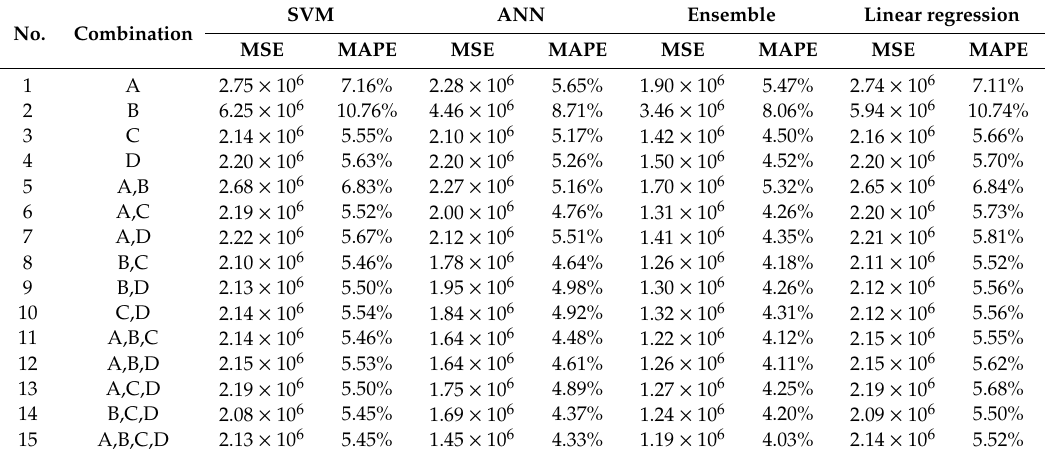
Table 6. Ec results for the 15 combinations predicted using four machine learning (ML)